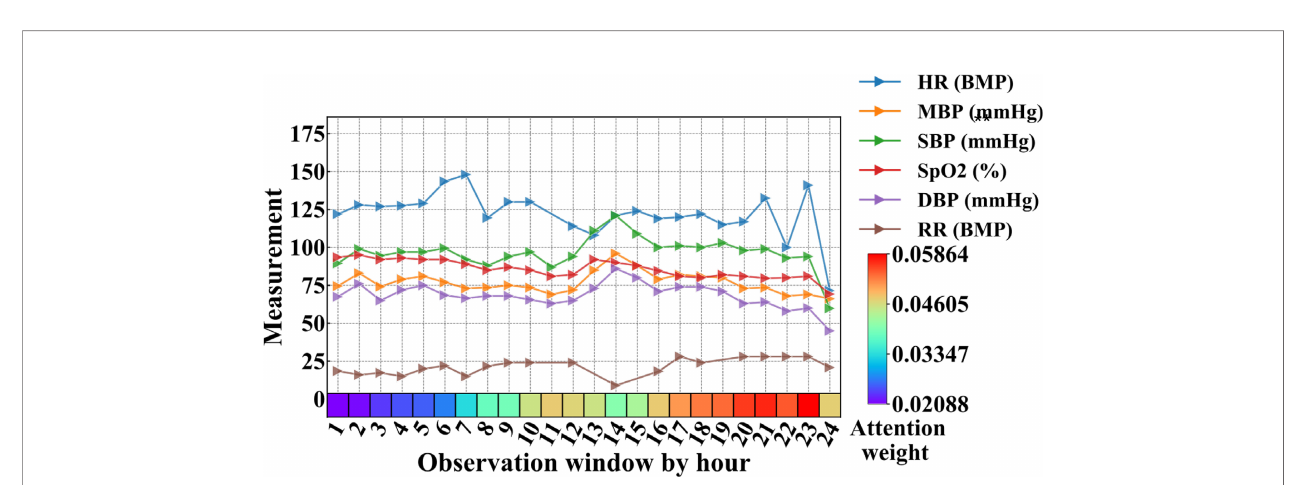
FIGURE 9 | Clinical features and attention weights of one patient in the 24-hour observation window who passed away after 12 hours (prediction window, not shown in fi gure) from MIMIC-III. BMP, beats per minute; DBP, diastolic blood pressure; HR, heart rate; MBP, mean blood pressure; RR, respiratory rate; SBP, systolic blood